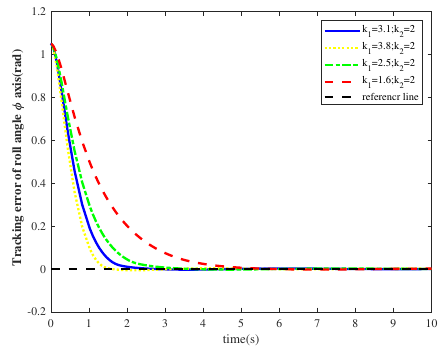
Figure 6. φ of different k 1 and k 2 .